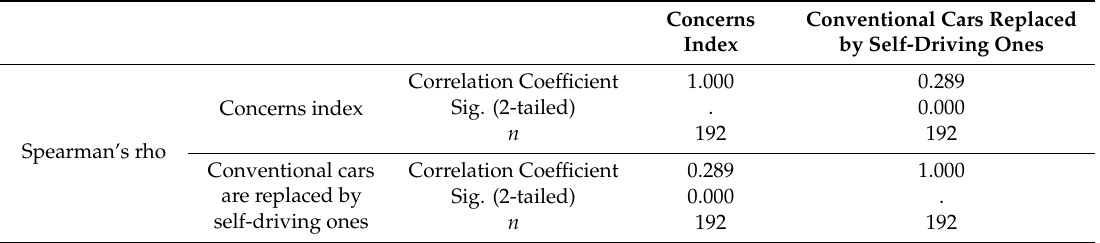
Table 16. Correlations concerns index and conventional cars are completely replaced by